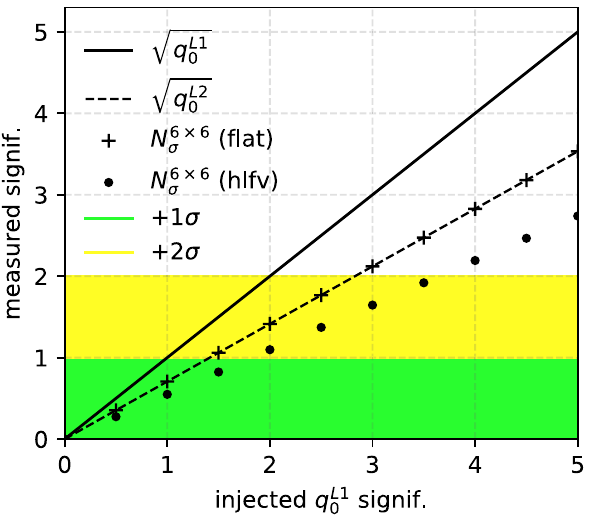
Fig. 6 The maximum neural network score from training a classifier Fig. 5 Significance measured from the Asimov data for increasing to distinguish the e μ from μ e samples with (asym) and without (sym) a injected signal, comparing results of the N σ , q L 1 and q L 2 tests. Results BSM contribution. The green (yellow) and blue bands represent (twice) 0 0 for the Higgs LFV example and the ideal (flat) scenario are shown. The the standard deviation over 10 bootstrap samples.The separation power green and yellow bands correspond to the 1 σ and 2 σ deviations from is shown as a function of the injected signal fraction (bottom scale) the symmetry (no signal) assumption, respectively and the corresponding significance calculated with the ideal q L 1 Note that these results are not directly comparable to the binned DDP because it is not possible to ignore signal statistical